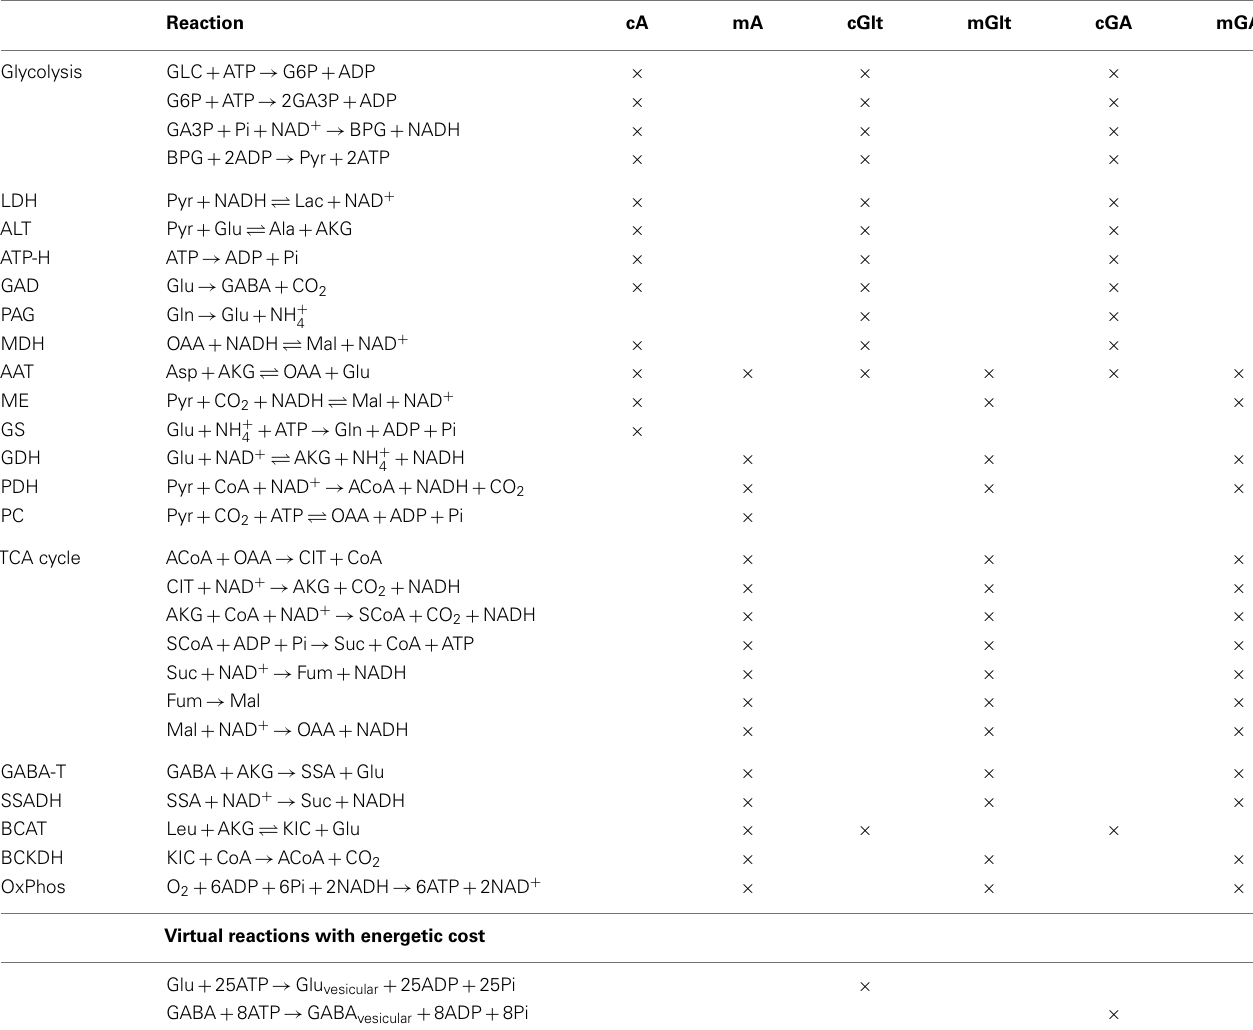
Table 1 | List of reactions included in the metabolic network